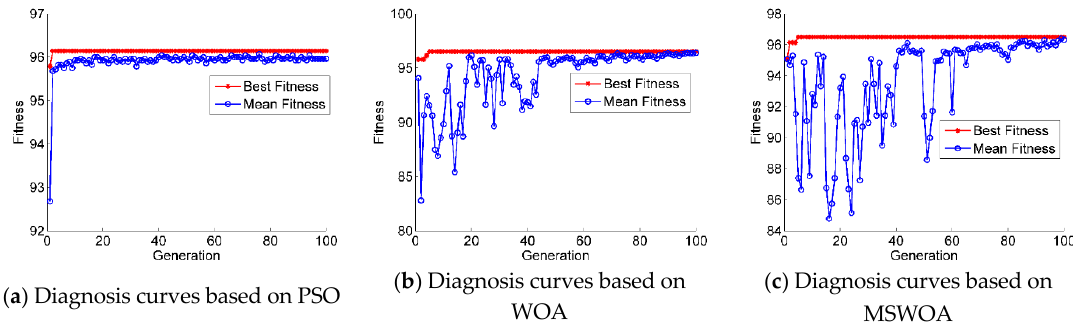
Figure 21. Fault diagnosis accuracy curves of the three methods optimized SVM.